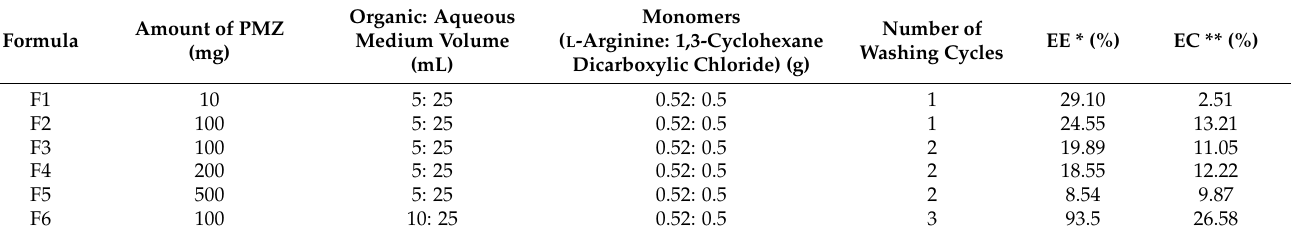
Table 1. Summary of the composition and evaluation parameters of formulas used in developing the taste masked